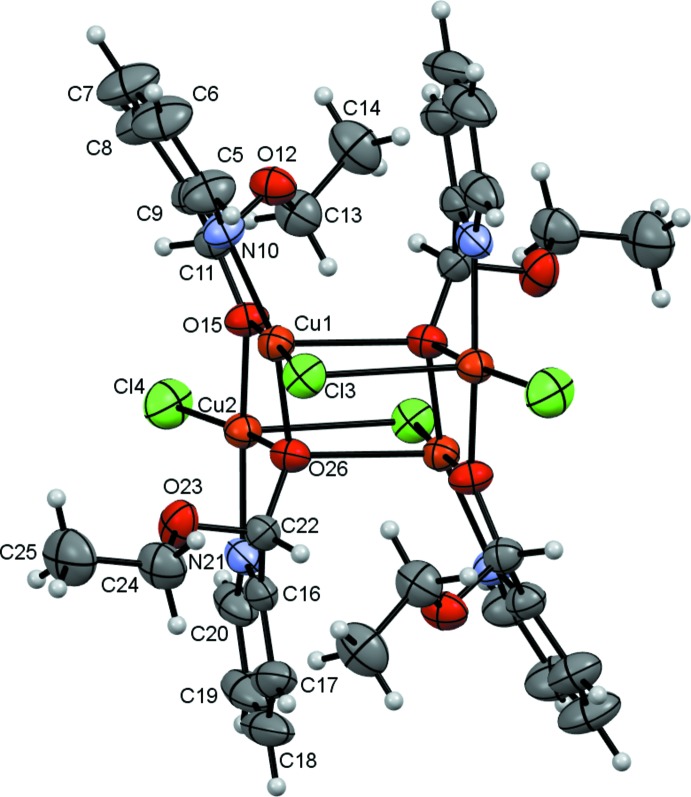
The structure of II with ellipsoids drawn at the 50% probability level. Unlabelled atoms are generated by the symmetry operation 1 − x, 1 − y, 1 − z.